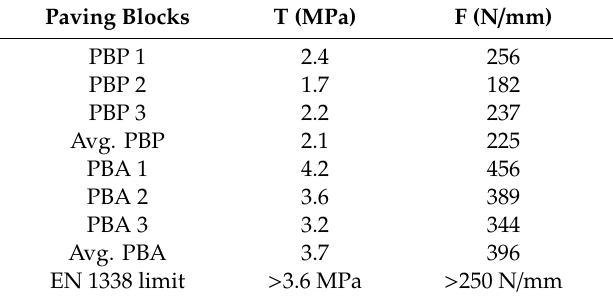
Table 5. Tensile splitting test results and limits.